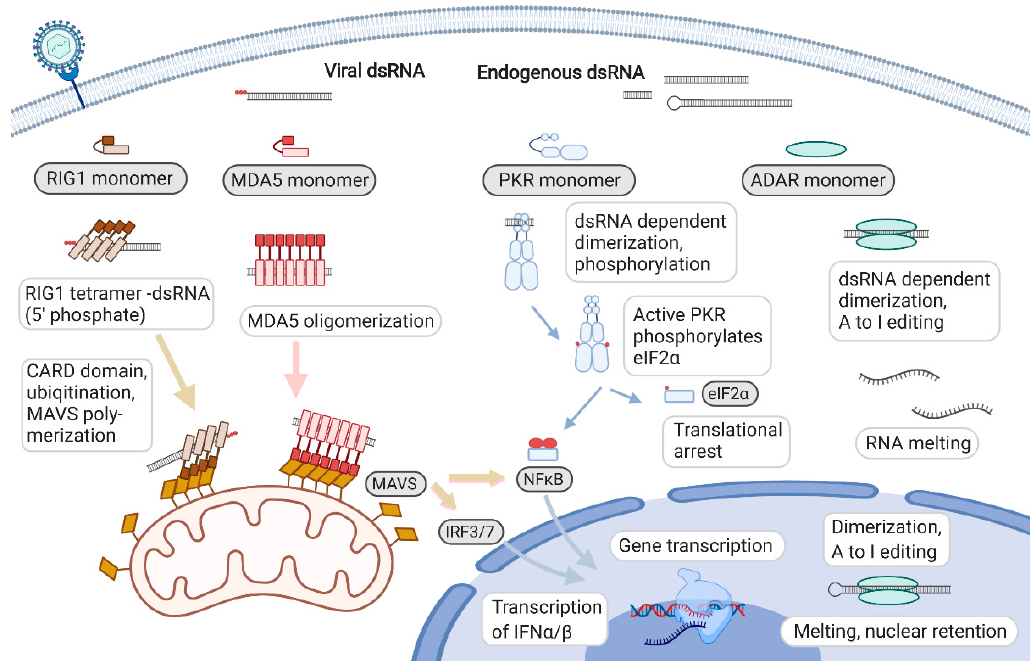
Figure 3. Double-stranded RNA (dsRNA) sensor proteins and activation of innate immunity. Viral dsRNA (including 5 ′ phosphorylation) or dsRNA from mitochondria and repetitive elements in the cytoplasm are recognized by dsRNA sensors retinoic acid-inducible gene I (RIG1), melanoma differentiation-associated gene 5 (MDA5), protein kinase R (PKR) and ADAR. RIG1 requires the 5 ′ phosphate group to initiate oligomerization, and MDA5 forms long dsRNA-dependent polymers. Both structures induce mitochondrial antiviral signaling (MAVS) polymerization and, eventually, caspase and interferon signaling. PKR binds short dsRNA molecules, dimerizes and becomes activated through autophosphorylation. Activated PKR dissociates from dsRNA, phosphorylates eukaryotic initiation factor 2 α (eIF2 α ) (which, in turn, inhibits translation globally) and triggers an interferon response. ADAR is present in both the nucleus and cytoplasm and antagonizes dsRNA signaling by melting the RNA hybrid. Figure created with Biorender.com.